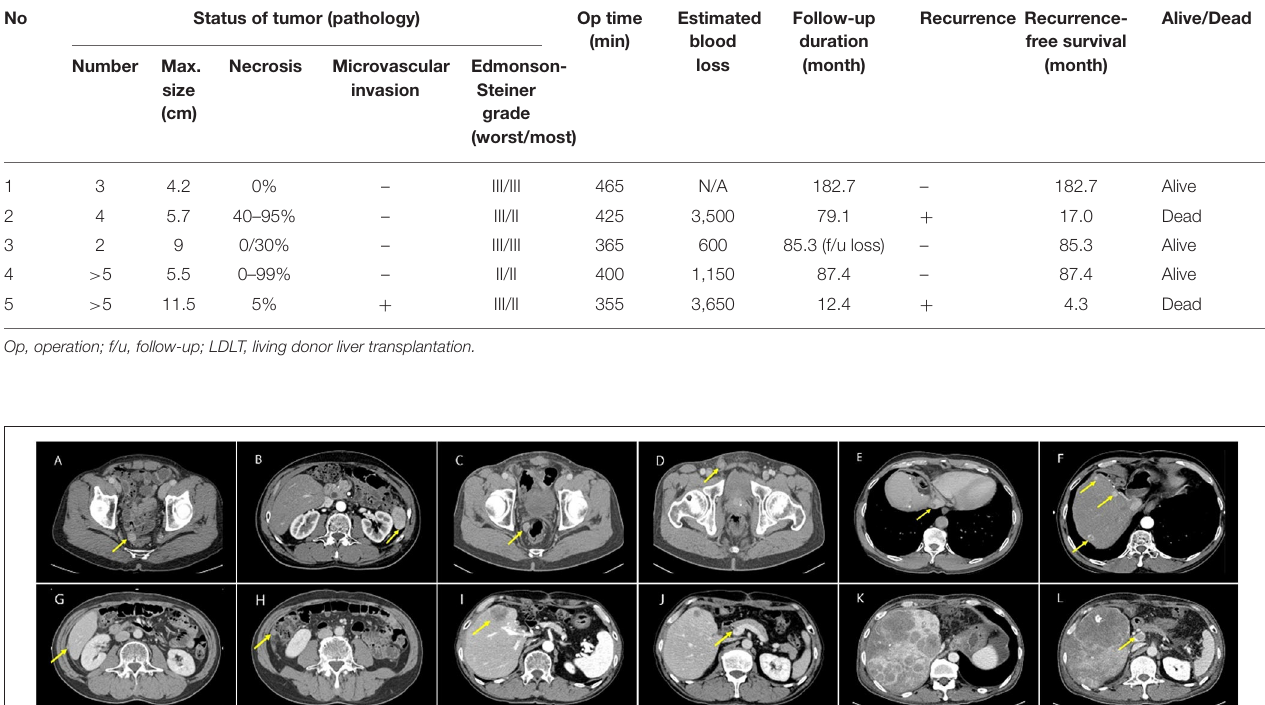
TABLE 2 | Postoperative findings and follow-up after LDLT. No Status of tumor (pathology) Op time Number Max. size